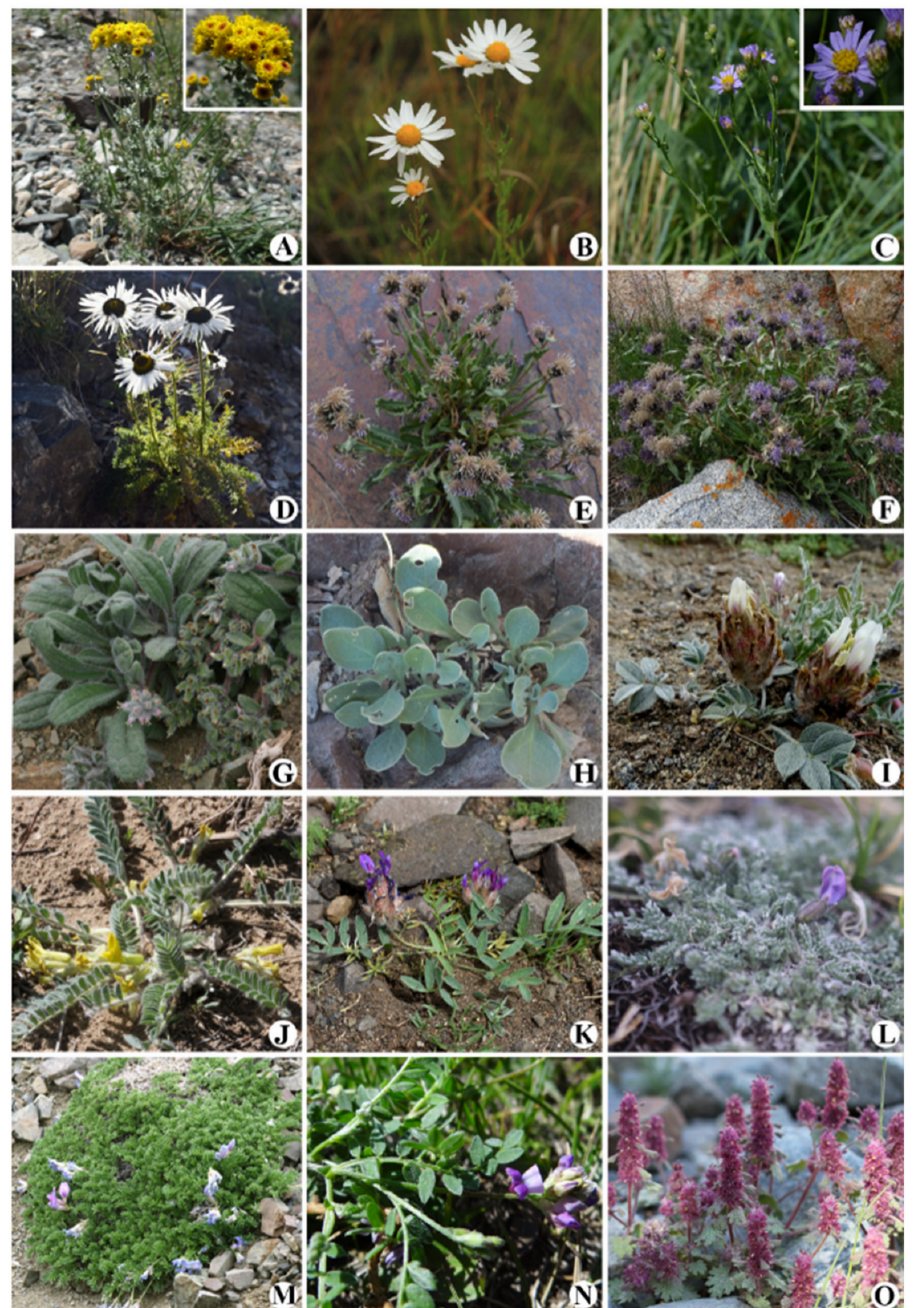
Figure A1. Representative taxa of the endemic vascular plants of Mongolia. ( A ) Ajania grubovii ; ( B ) Chrysanthemum chalchingolicum ; ( C ) Aster sanczirii ; ( D ) Tanacetum chanaicum ; ( E ) Saussurea saichanen- sis ; ( F ) Saussurea odorata ; ( G ) Craniospermum pseudotuvinicum ; ( H ) Galitzkya macrocarpa ; ( I ) Astragalus koslovii ; ( J ) Astragalus sanczirii ; ( K ) Astragalus tamiricus ; ( L ) Oxytropis sutaica ; ( M ) Oxytropis fragili- folia ; ( N ) Oxytropis tenuis ; ( O ) Lagopsis darwiniana . Photos: ( A , N ) by V.Gundegmaa; ( B , H , J , L , O ) by B.Oyuntsetseg; ( F , G , I , M ) by A.Pyak; ( C , E ) by HJ.Choi; and ( D , K ) by S.